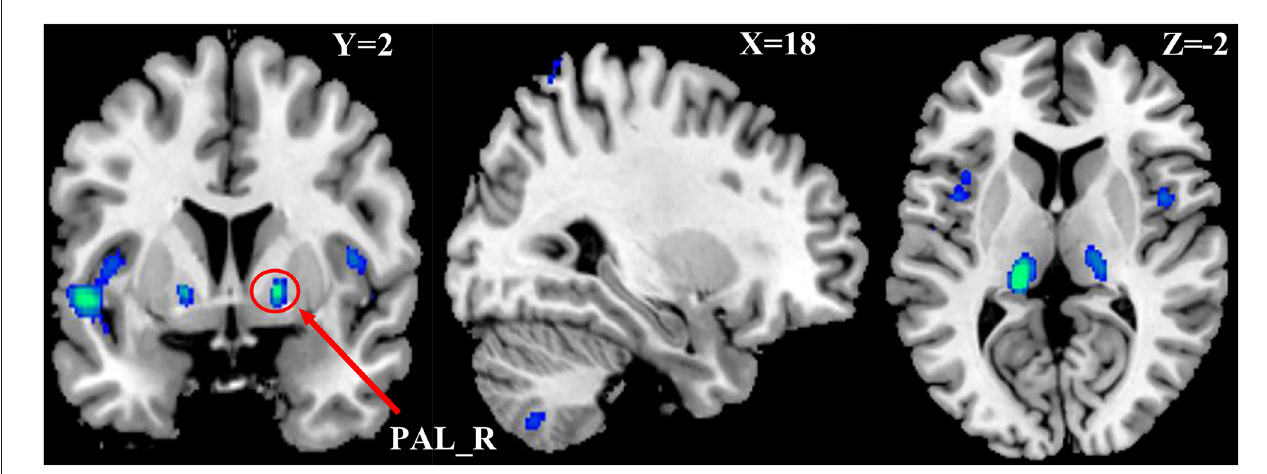
FIGURE1 Differences in Gray Matter Volume among the three ADHD patient groups. P < 0.05, FWE corrected. Differences were mainly found in the basal ganglia, cerebellum, insula, and left part of the superior temporal cortex.